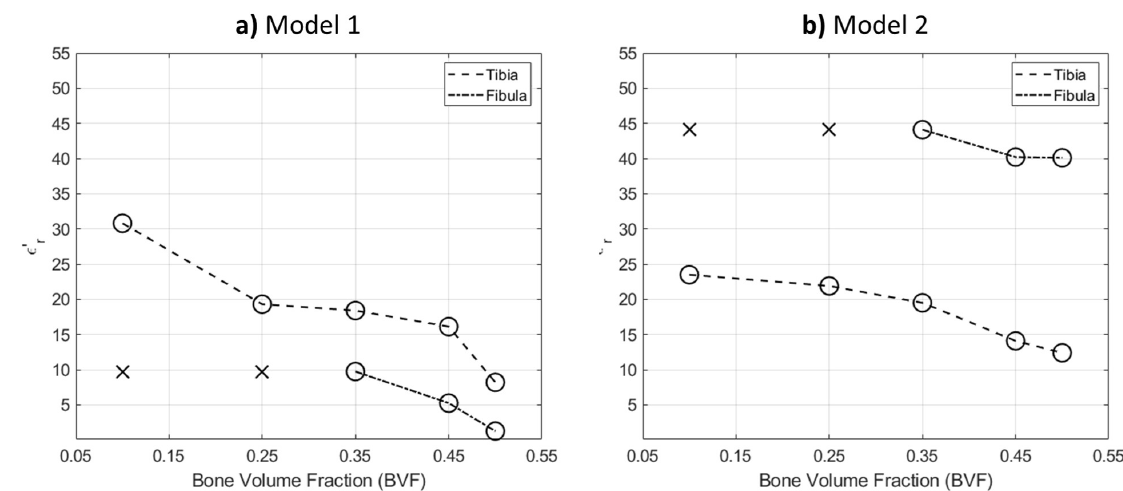
Figure 11. Line plot of the real part relative permittivity mean value of extracted bones: ( a ) model 1 and ( b ) model